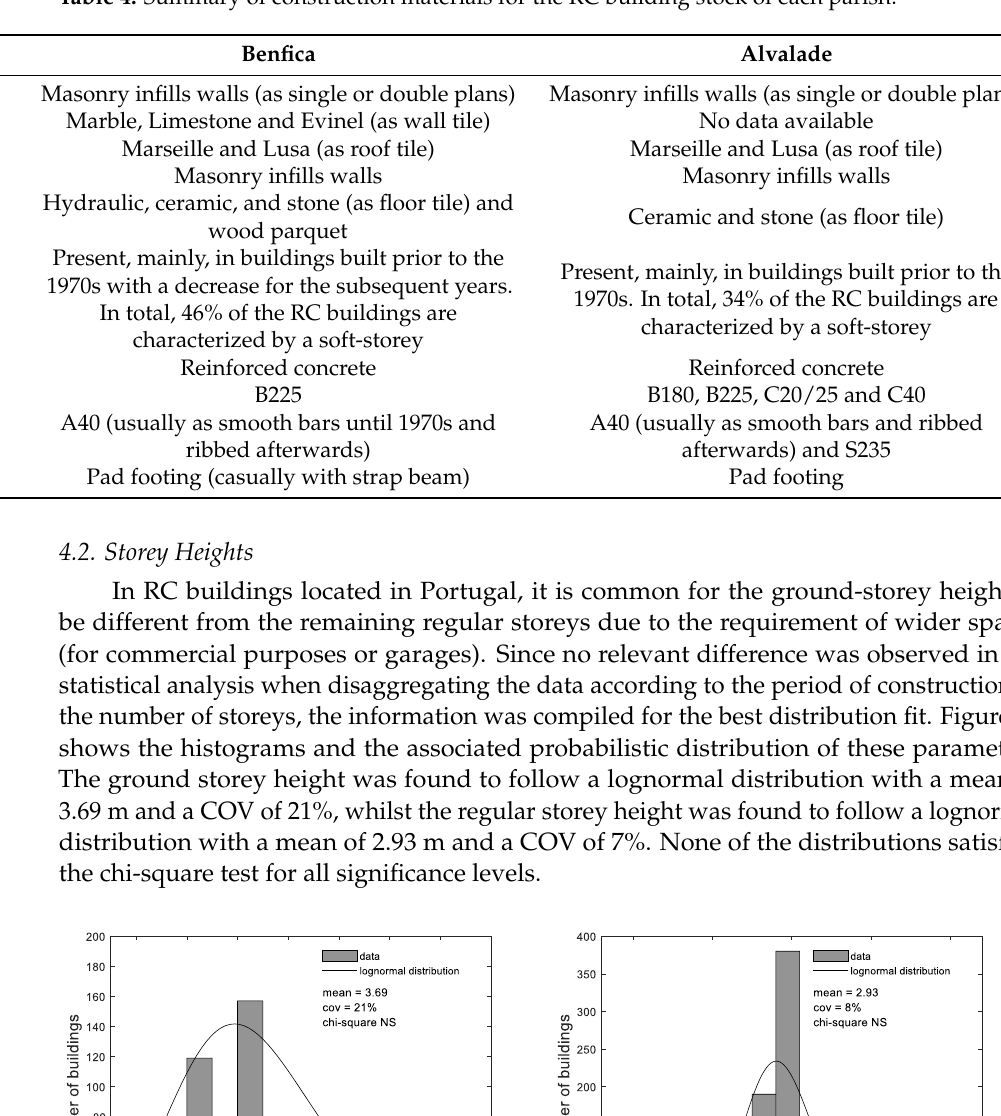
Table 4. Summary of construction materials for the RC building stock of each parish.